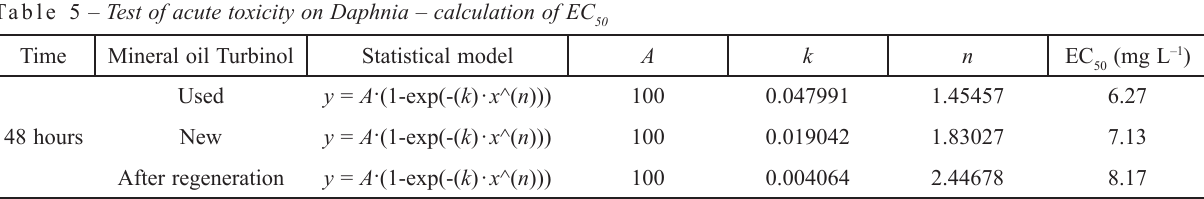
Table 5 – Test of acute toxicity on Daphnia – calculation of EC